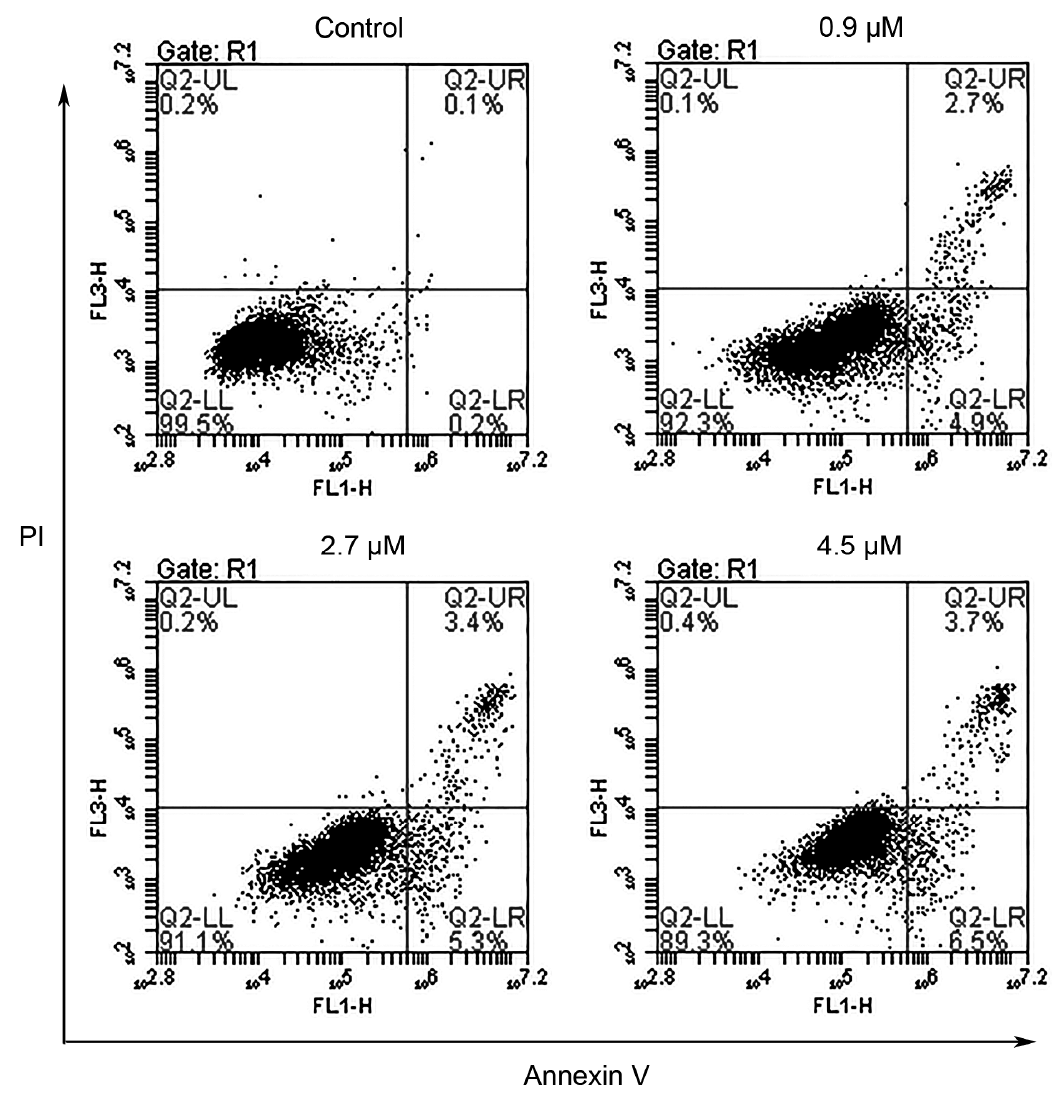
Figure 4. Compound b17 induced apoptosis in HepG-2 cells at concentrations of control, 0.9 µM, 2.7 µM, and 4.5 µM in a 12 h exposure. PI: propidium iodide.